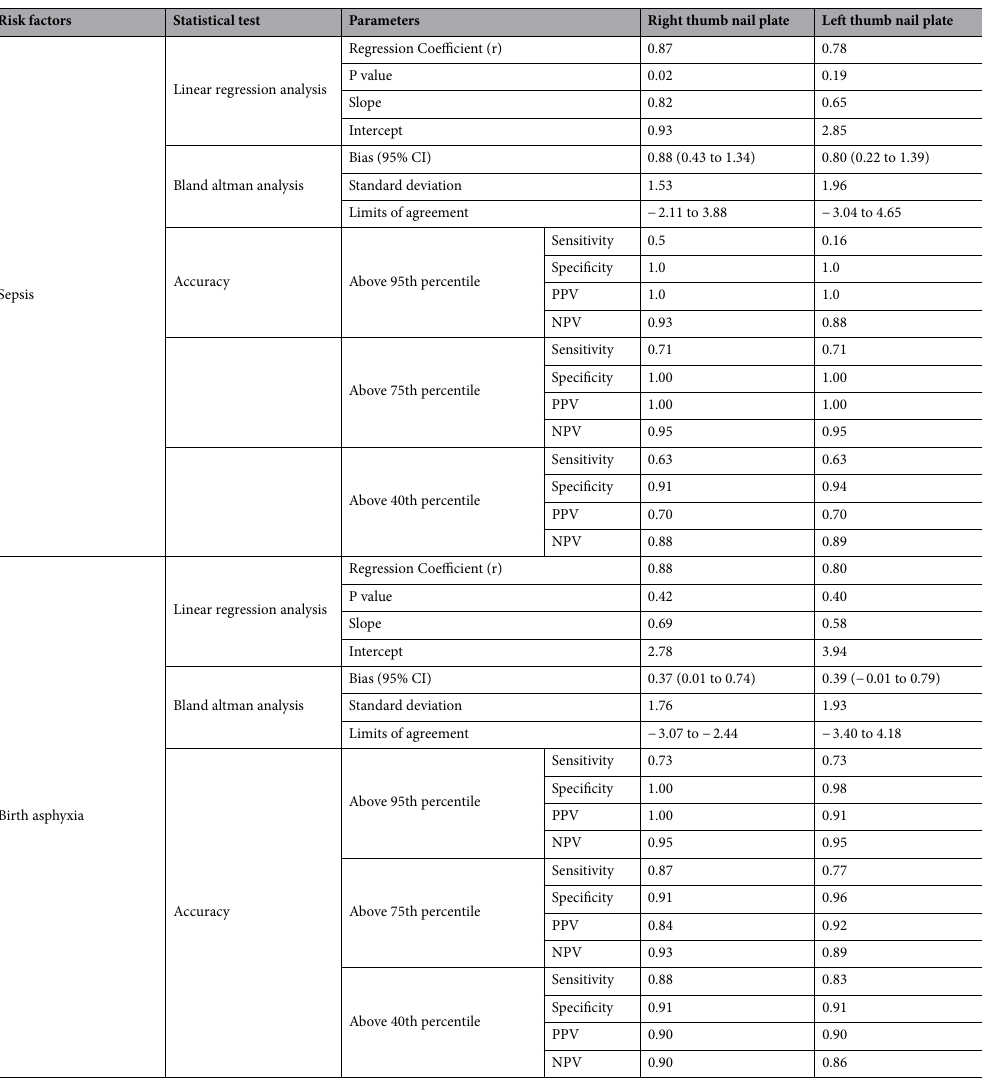
Table 3. The correlation between bilirubin values obtained from AJO-Neo and TSB along with predictive indices of AJO-Neo in neonates with AAP designated risk factors of